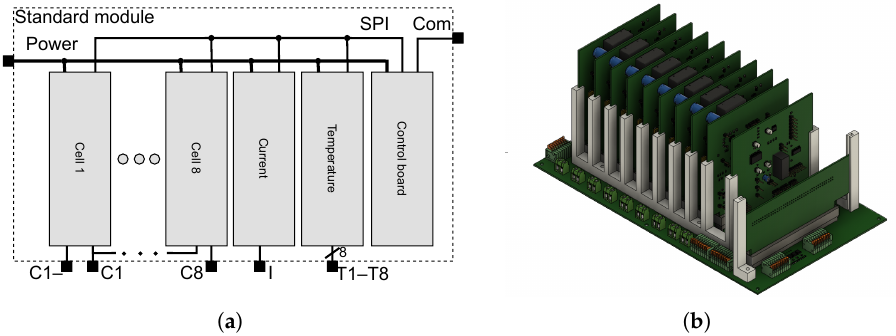
Figure 2. Standard module of the developed platform: Block diagram ( a ) and 3D rendering ( b ). The control board is connected to the other submodules via a Serial Peripheral Interface (SPI) bus, and all the submodules are powered by a 48 V power bus. This high voltage